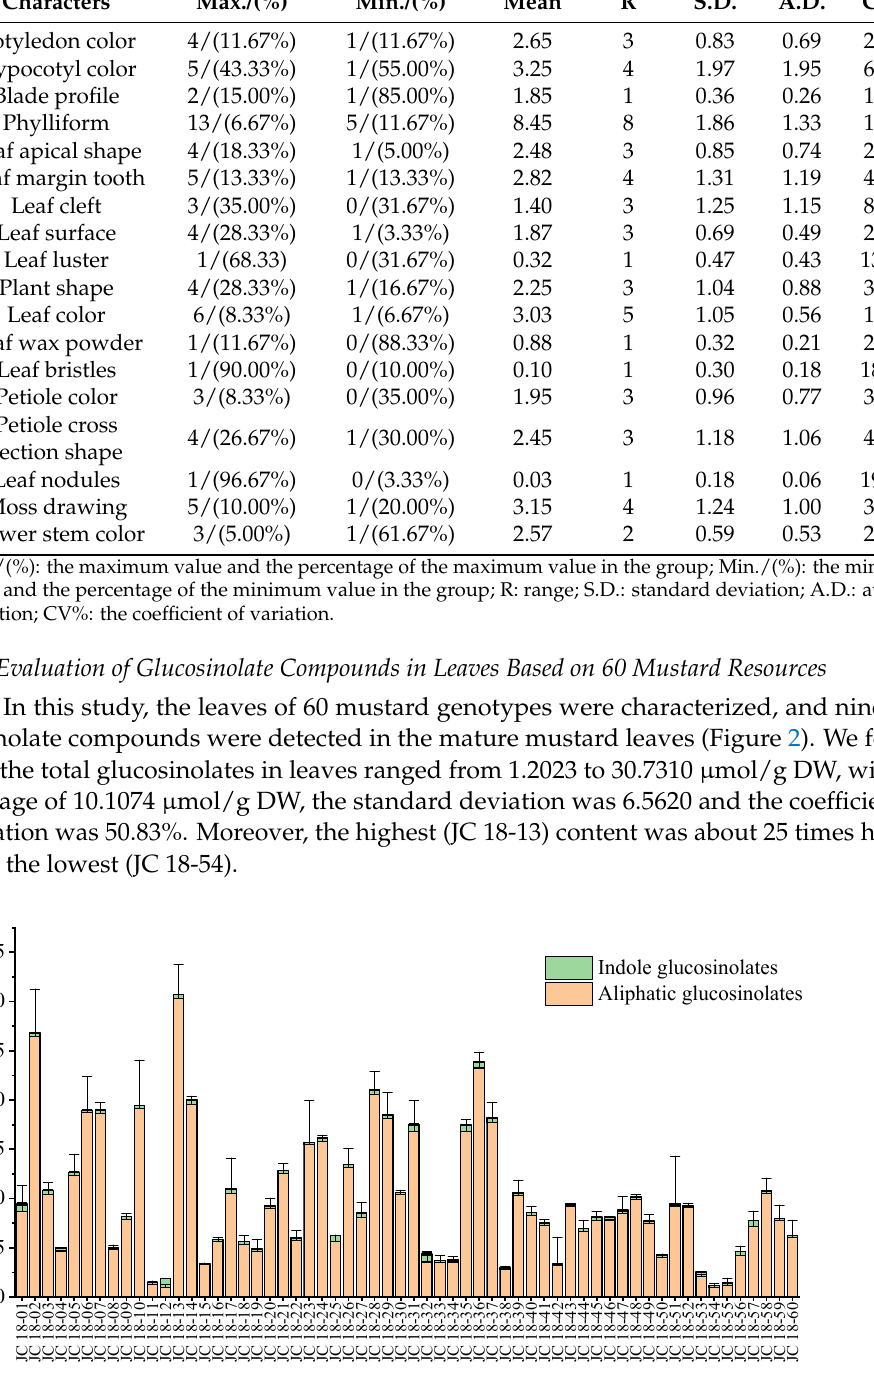
Figure 2. Variation of total glucosinolate contents in different mustard resources’ leaves.